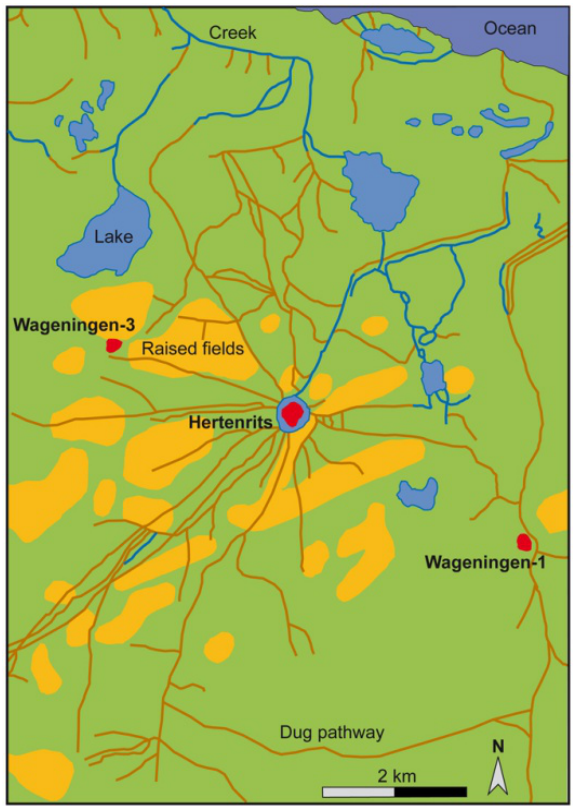
Figure 12. Human modifications in the Hertenrits surroundings with the three residential mounds (redrawn after Boomert